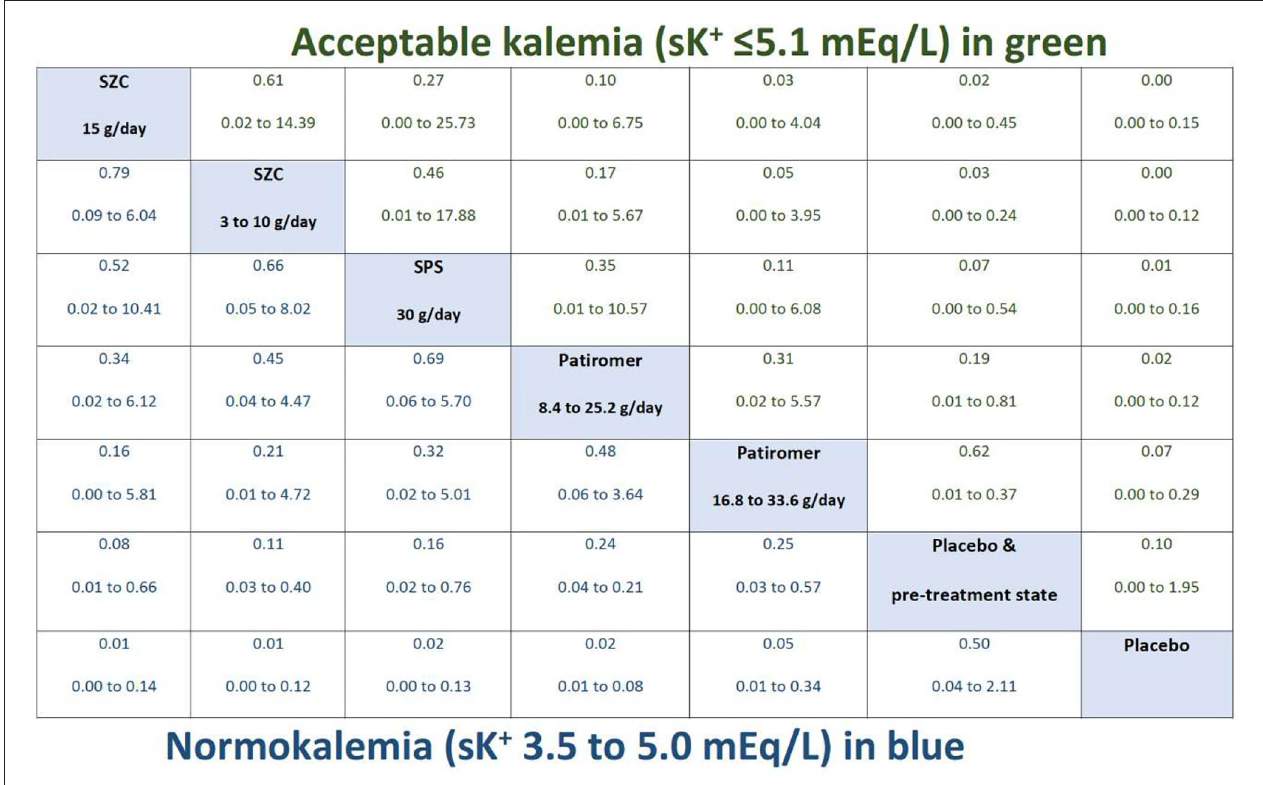
FIGURE 2 | League table showing effect estimates in OR and 95% CrI for the outcomes of normokalemia (sK + 3.5 to 5.0 mEq/L) and acceptable kalemia (sK + ≤ 5.1 mEq/L) corresponding to all evaluated potassium-binding polymers for each possible (direct and indirect) comparison. CrI, credible intervals; OR, odds ratio; SPS, sodium polystyrene sulfonate; SZC, sodium zirconium cyclosilicate.